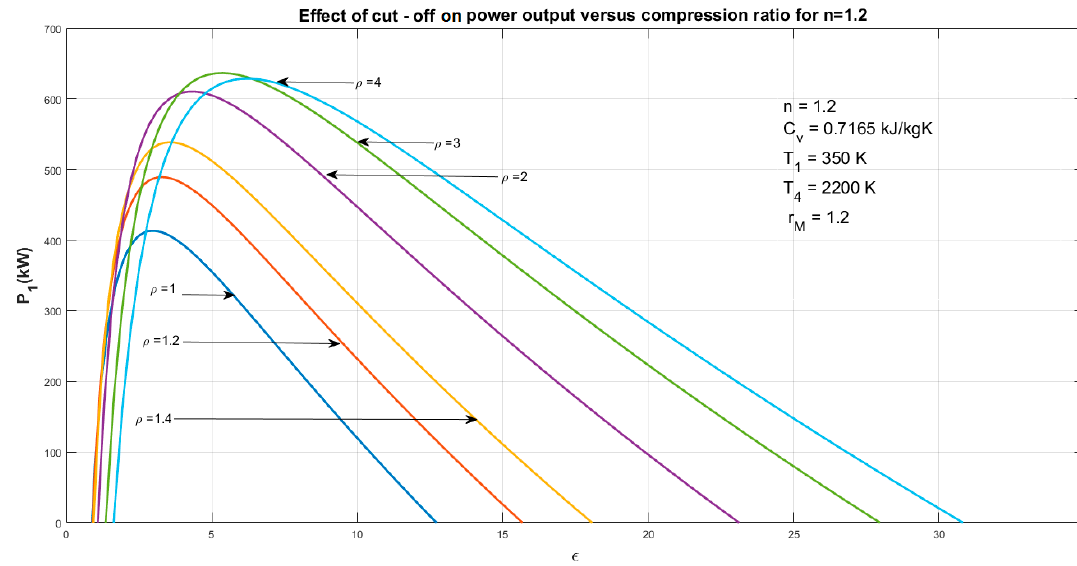
Figure 2. Impact of n ( n < k ) on P 1 – ε ( a ), 𝜂 1 – ε ( b ) and P 1 – 𝜂 1 ( c ) relations.